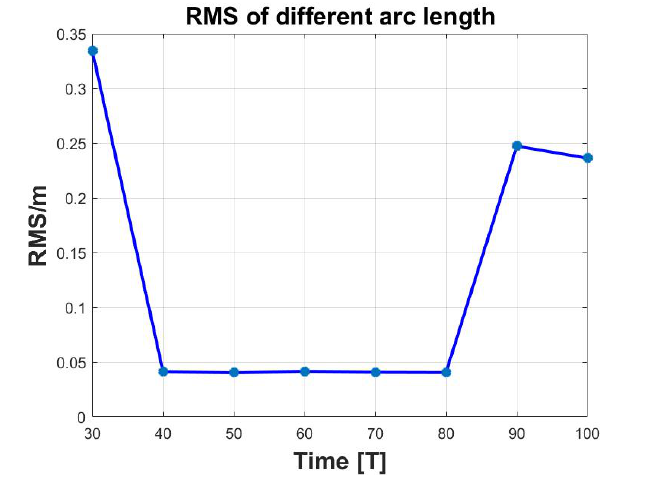
Figure 3. RMS of different arc